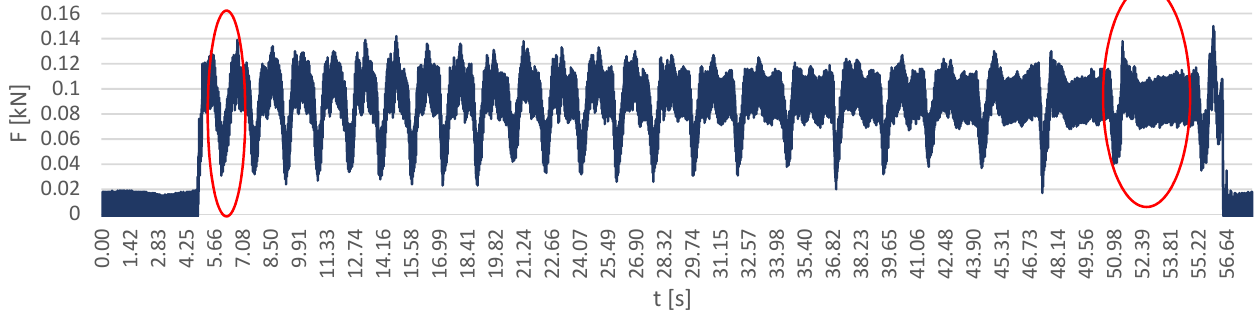
Figure 3. Evolution of forces versus time with execution to the point of refusal—10 kg load.